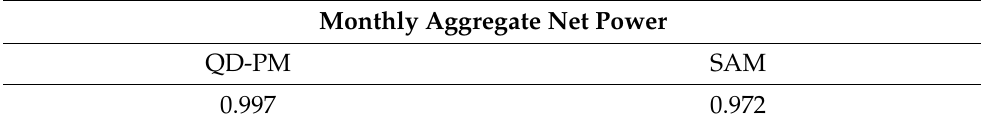
Table 5. R 2 Net energy monthly validation comparison between PM and